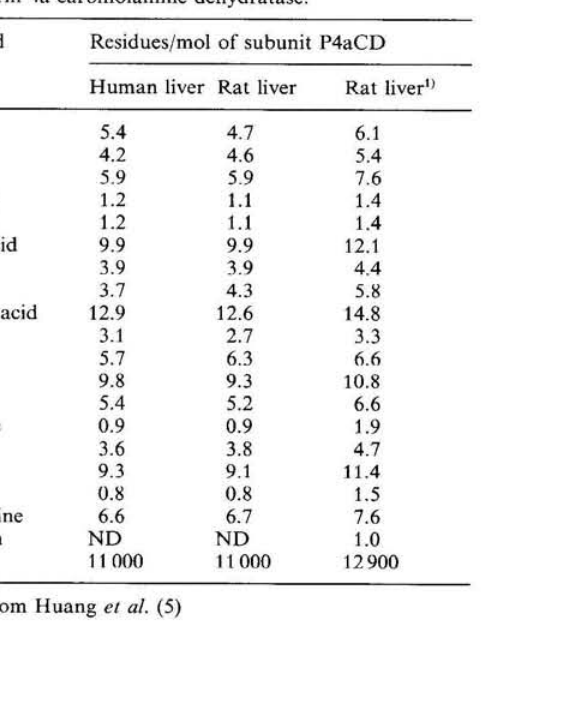
Table 2. Comparison of amino acid composition of rat and human pterin 4a-carbinolamine dehydratase. Amino